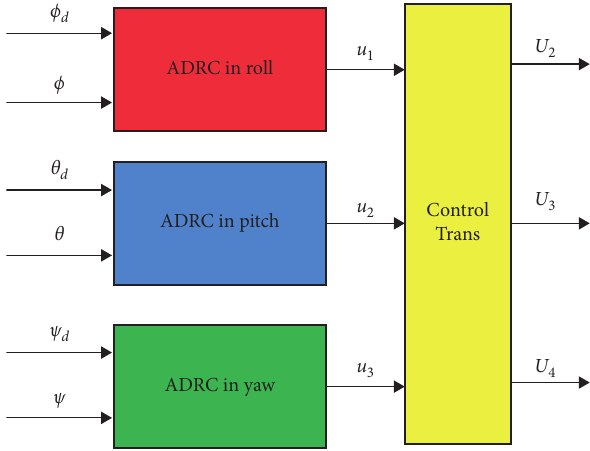
Figure 5: Attitude controller structure